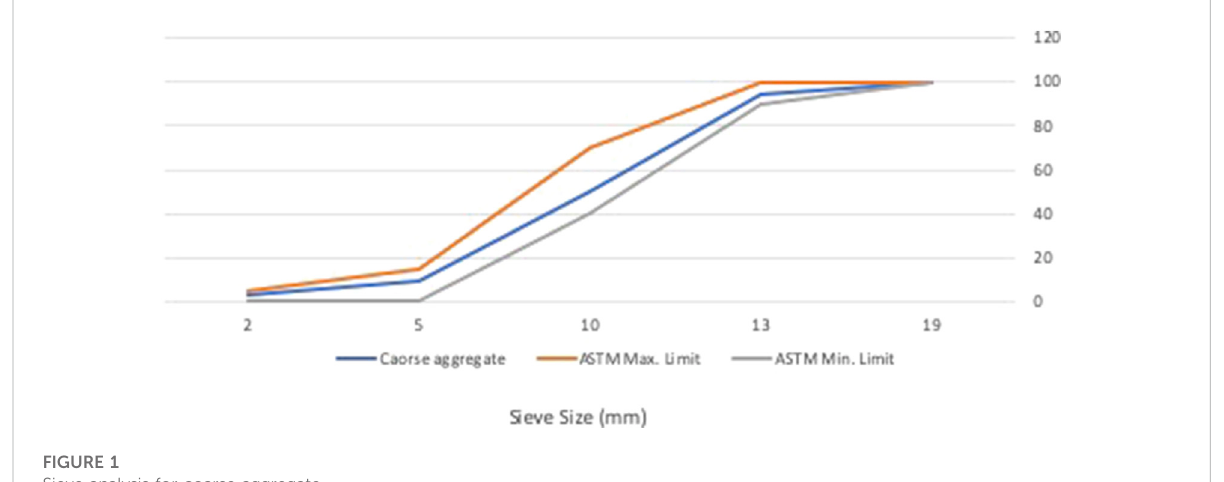
FIGURE 1 Sieve analysis for coarse aggregate.